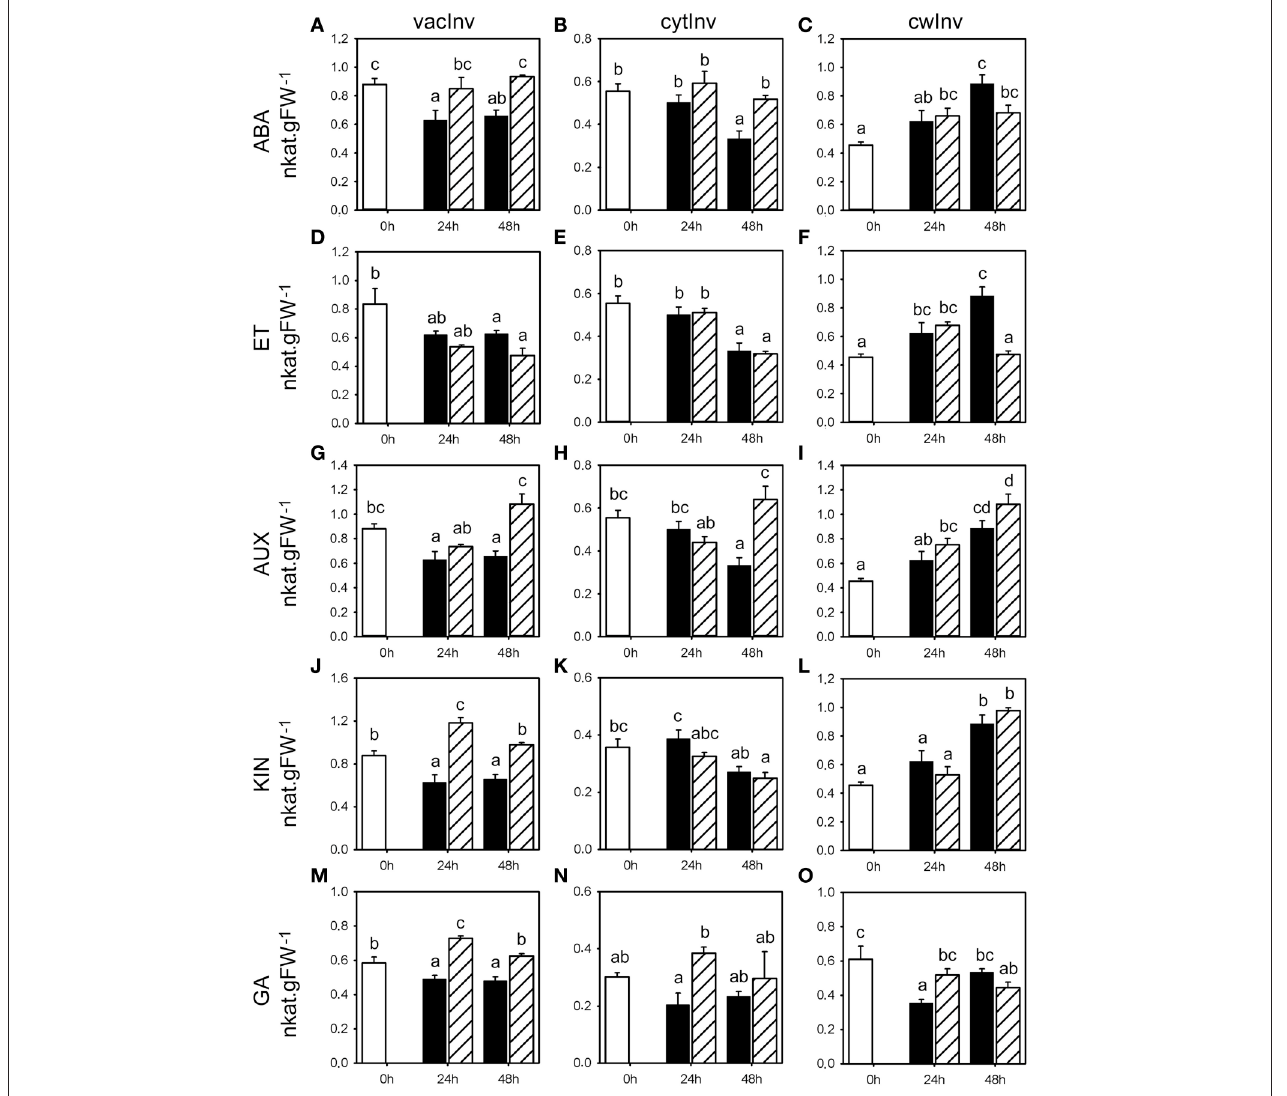
FIGURE 3 | Invertase enzyme activities following phytohormone treatments. Enzyme activities of vacInv, cytInv, and cwInv (nkat.gFW − 1 ) in the first basal cm of stubble of 4-week old perennial ryegrass seedlings 24 or 48h post ABA (A–C) , ET (D–F) , AUX (G–I) , KIN (J–L) , or GA (M–O) treatment, compared to untreated controls (0h). Open bars, untreated controls; closed bars, mock treatment; dashed bars, phytohormone treatment. Values represent the mean of three biological replicates ± SE. Different letters indicate statistical significance at p < 0.05 . Representative examples are shown from one of the three